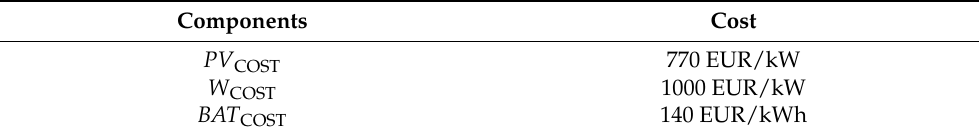
Table 3. Costs of off-grid PV-wind battery system elements.